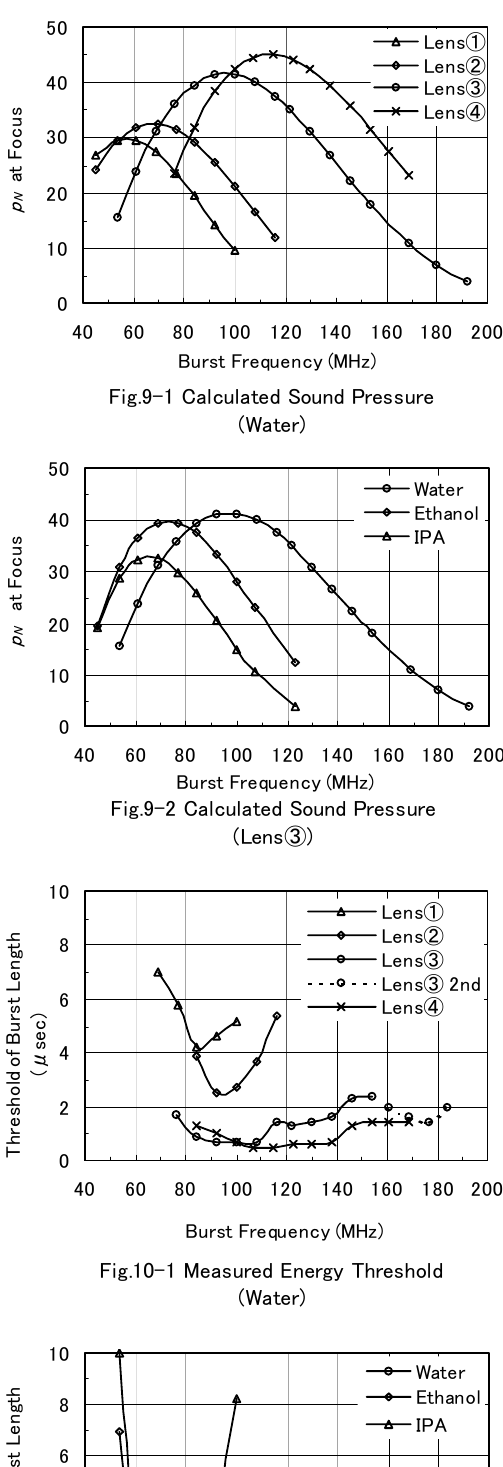
Fig.10-1 Measured Energy Threshold